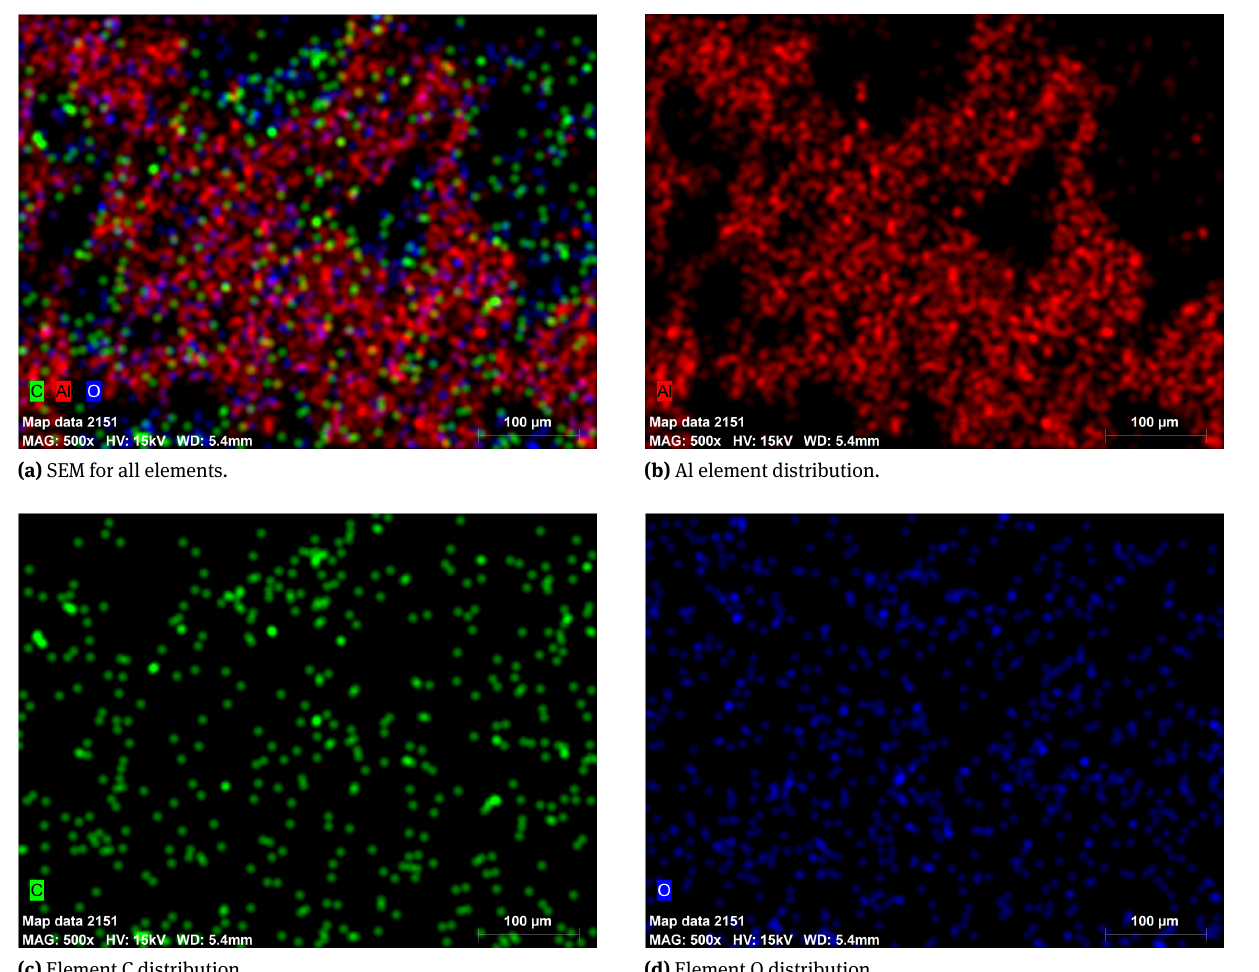
Figure 11: EDEX mapping results with, KMnO 4 (3g/l) concentration.